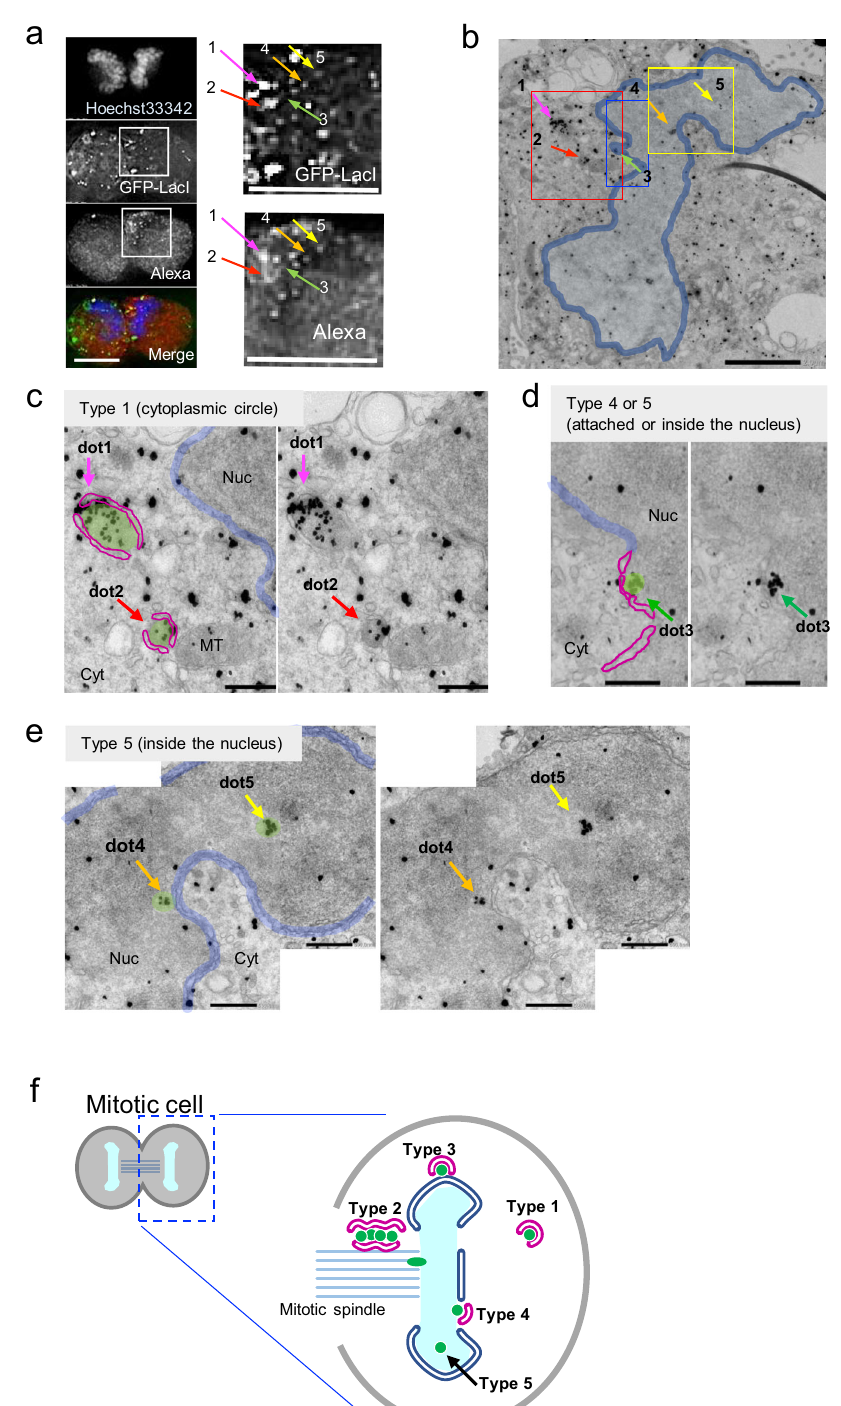
Fig. 4 Immuno-CLEM (iCLEM) images of telophase cells. HeLa/GFP-LacI cells were transfected with pLacO-pEF1 α -RFP, and then fi xed and subjected to iCLEM. a Fluorescence microscopic images. Left: Overview fl uorescence images. DNA (stained with Hoechst 33342, blue), GFP-LacI (green), and Alexa- nanogold (red) in the merged image. Right: Enlarged images of the white-boxed region in the left panel. Numbers 1 – 5 correspond to the dots analyzed in b – e . Bars, 10 μ m. b Low-magni fi cation electron micrograph of the telophase cell shown in a . Blue contour, the edge of telophase chromosome mass. Arrows indicate the positions analyzed. Red-, blue-, and yellow-boxed regions are enlarged in c – e , respectively. Bar, 2 μ m. c Representative type 1, from the red- boxed region in b . Red contour, NE-like structures. Blue contour, edge of the nucleus. Arrows indicate the positions of dots 1 and 2. Nuc, Cyt, and MT label the nucleus, cytoplasm, and mitochondria, respectively. Bars, 500 nm. d Representative type 4 or 5, from the blue-boxed region in b . Red contour, NE-like structures. Blue contour, edge of the nucleus. Arrows indicate the positions of dot 3. Nuc and Cyt label the nucleus and cytoplasm, respectively. Bars, 500 nm. e Representative type 5, from the yellow-boxed region in b . Blue contour, edge of the nucleus. Arrows indicate the positions of dots 4 and 5. Nuc and Cyt label the nucleus and cytoplasm, respectively. Bars, 500 nm. f Diagrams of typical localizations of transfected DNA in telophase